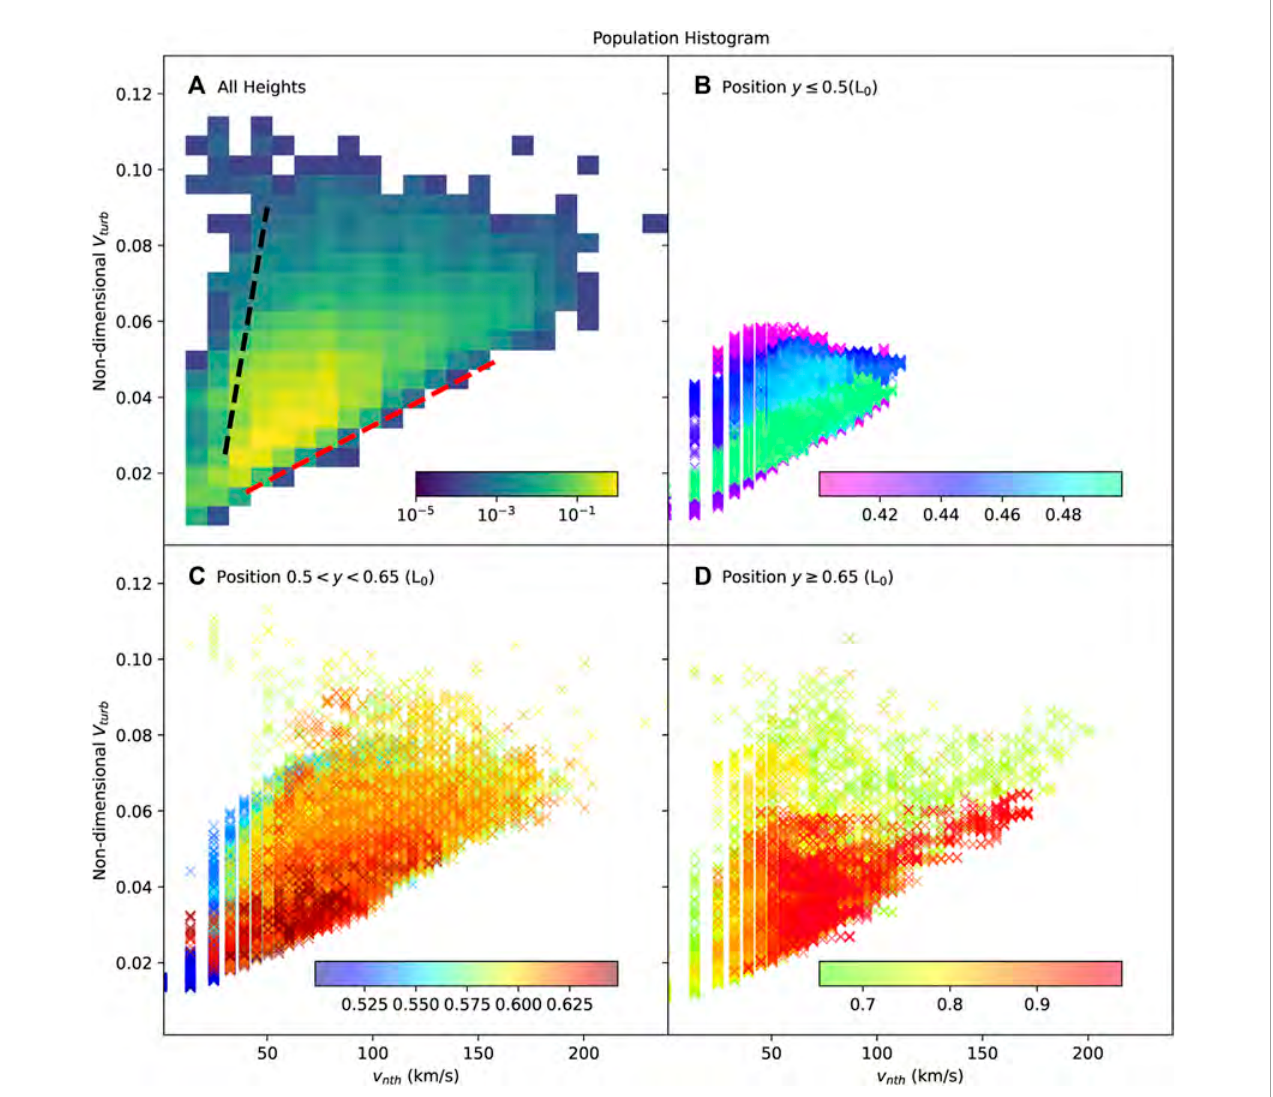
FIGURE 11 Distribution of plasma turbulence strength V turb versus non-thermal velocity v nth . Panel (A) is the 2D histogram of v nth - V turb map, which shows the population of samples in all heights from y ∼ 0.4 L 0 to y ∼ 1.0 L 0 . The red and black dashed lines indicate two typical monotone correlations between v nth and V turb . Panels (B) (C) (D) show each sample on the v nth - V turb maps at different heights: near the flare loop-top region ( y ≤ 0 . 5 L 0 ), the above-the-looptop region (0 . 5 L 0 < y < 0 . 65 L 0 ), and CS regions ( y ≥ 0 . 65 L 0 ),